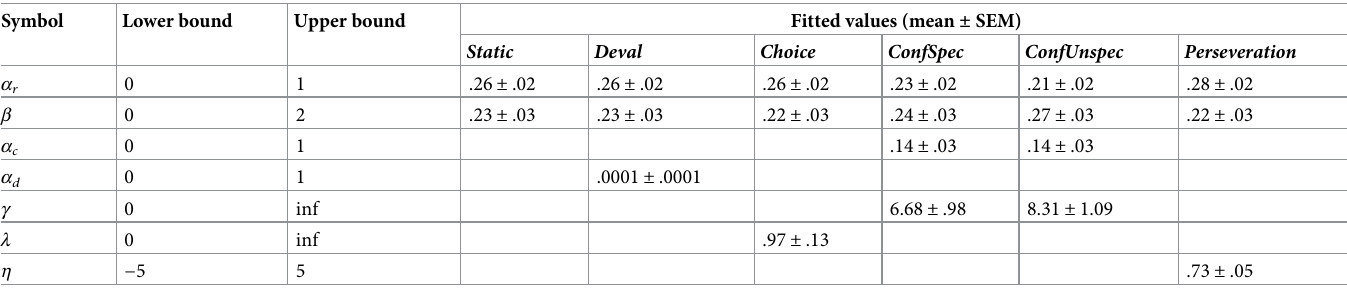
Table 2. Free model